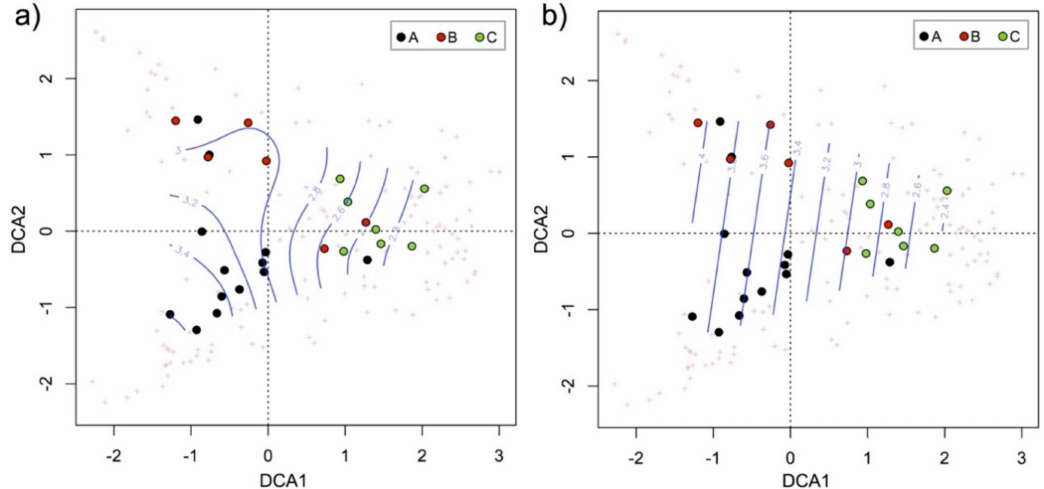
Figure A1. DCA ordination of grasslands relev é s overlapped with the MV (mowing tolerance, ( a ) and N (index of nutrients, ( b ) contour lines. The points indicate the relev é s: A, meadows; B, meadows-pastures; C, pastures. Eigenvalues for DCA axes are reported in Table